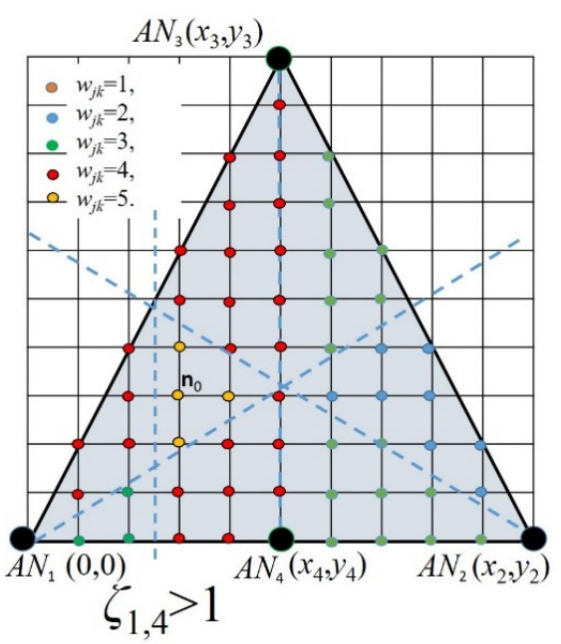
Figure 3. Illustration of a feasible vertex set reduction when four ANs are available and ζ 1,4 ≤ 1 is applied.